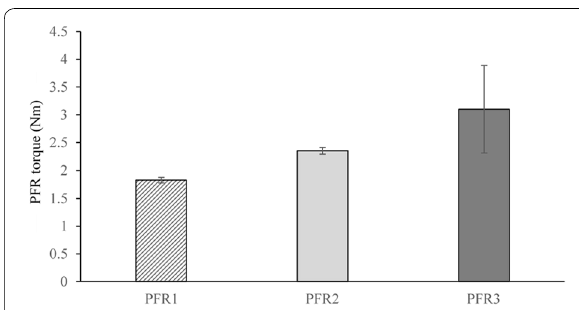
Fig. 9 Peak PFR torque in stance phase. The error bars represent standard deviation from the